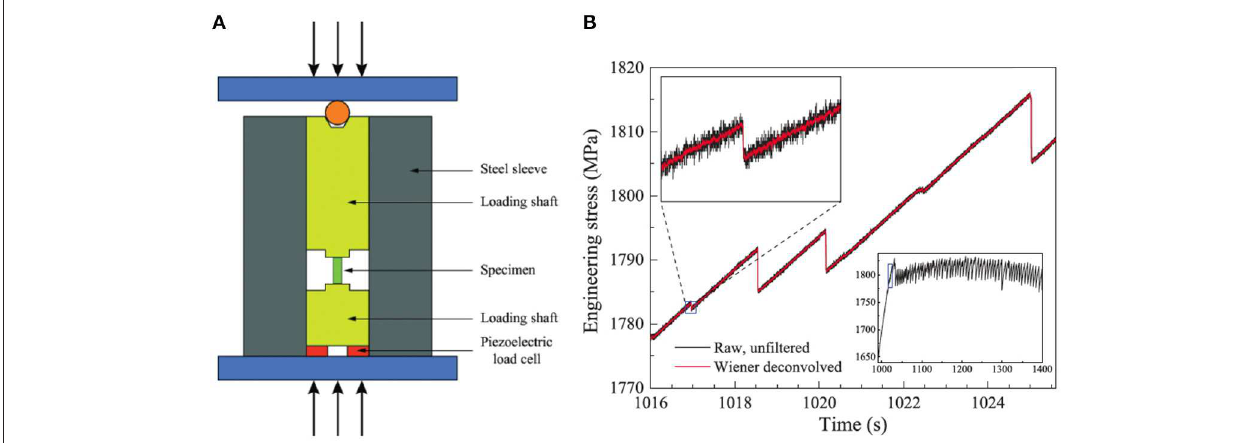
FIGURE 3 | Experimental setup and stress drops. (A) Schematic diagram of the experimental setup. Two tungsten carbide platens that are constrained by a steel sleeve compress the metallic glass sample, see [6] and references therein for details. (B) Lower-right inset: applied stress vs. time. Main figure: magnification of the data in the small window in the lower-right inset. Slip avalanches manifest as sudden drops in applied stress for constant-displacement-rate testing. Upper-left inset is further magnification, showing one stress drop. Black curves indicate the raw, unfiltered stress-time series, and red curves indicate the time series after Wiener deconvolution (see [6] and references therein) [Reprinted with permission from Antonaglia et al. [6] Copyright (2014) by the American Physical